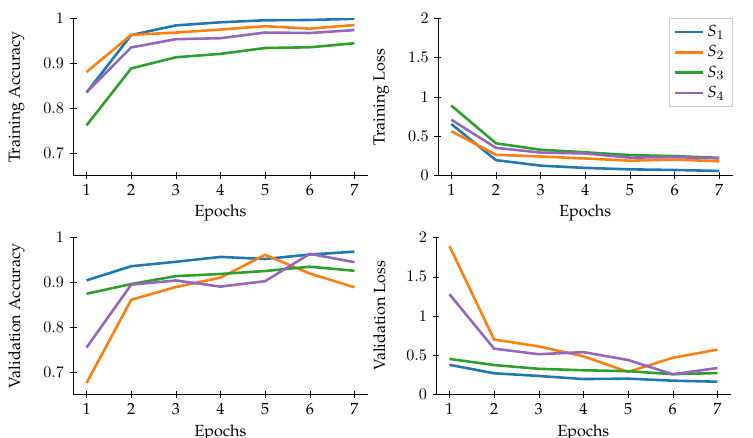
Figure 5. Training and validation accuracy and loss obtained with the different configurations from Table2